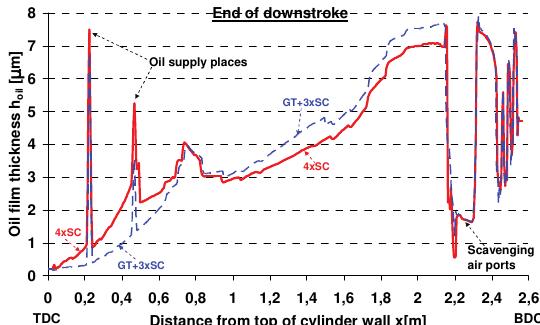
Fig. 9. Comparison of the oil film thickness h oil left by the ring pack along cylinder wall concerning piston ring pack configurations 4xSC and